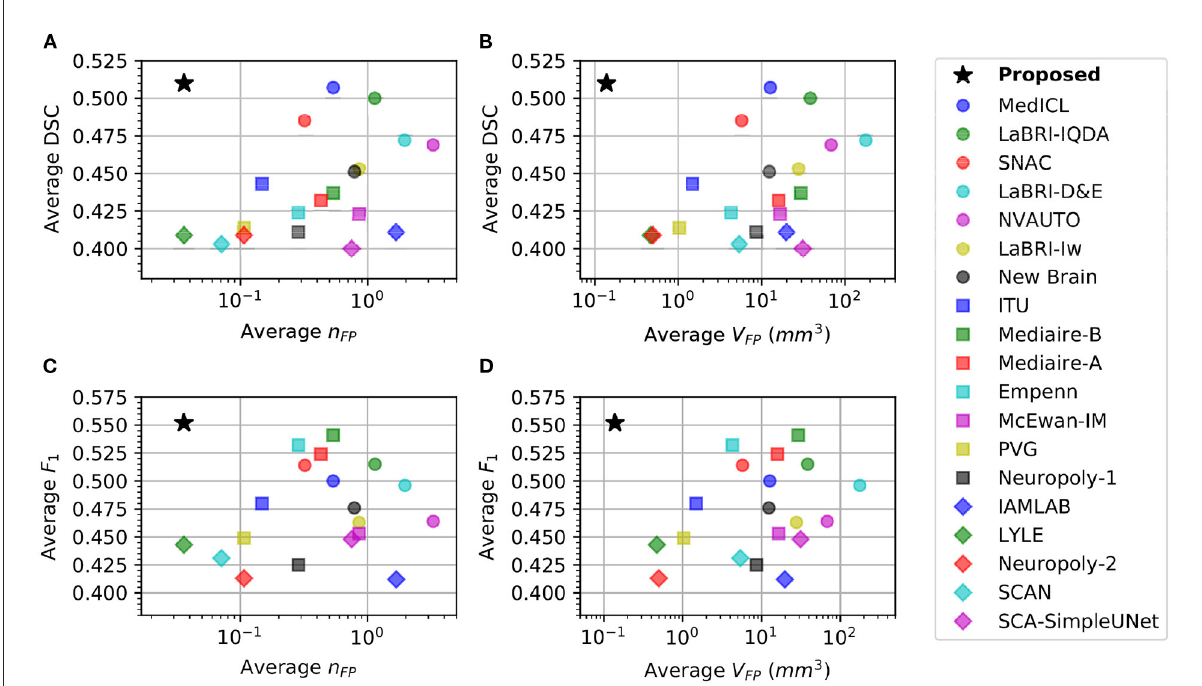
FIGURE4 Comparison of different methods in new lesion metrics (DSC and F 1 ) vs. no-new lesion metrics ( n FP and V FP ). X-axis denotes one of the no-new lesion metrics in logarithmic scale and Y-axis denotes one of the new lesion metrics. Star denotes the proposed pipeline. (A) Plot of average DSC vs. average false positive lesion count n FP . (B) Plot of average DSC vs. average false positive lesion volume V FP . (C) Plot of average F 1 vs. average false positive lesion count n FP . (D) Plot of average F 1 vs. average false positive lesion volume V FP